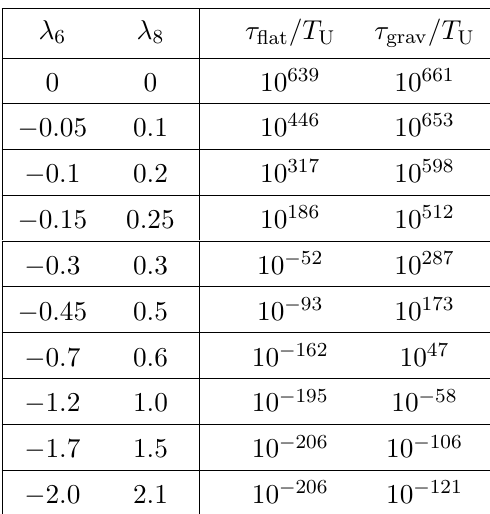
Table 1 . Tunneling time for di(cid:11)erent values of (cid:21) 6 and (cid:21) 8 , both for the (cid:13)at and curved spacetime cases. We note that although gravity tends to stabilize the EW vacuum (the tunneling time (cid:28) grav is always higher than the corresponding one in (cid:13)at spacetime (cid:28) (cid:13)at ), new physics has always a strong